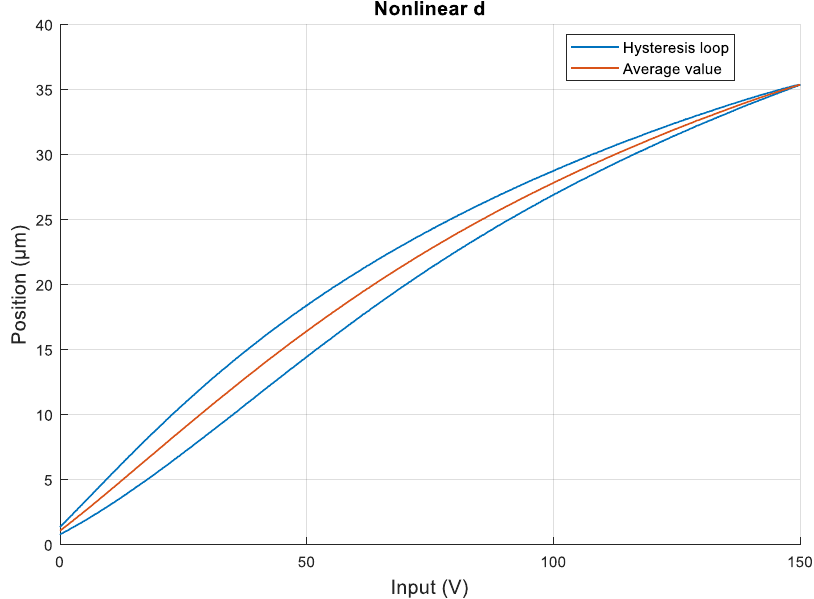
Figure 2. Nonlinear d curve.